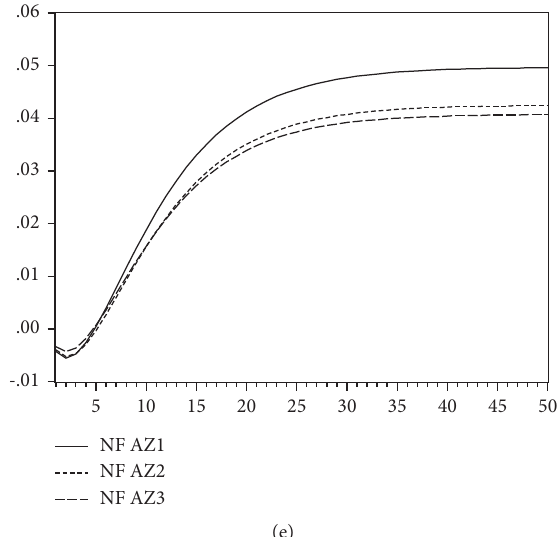
Figure 1: Technological innovation shock (1%), the dynamic response of variables under different degrees of investment openness. Note:1. The solid line, the short dotted line, and the long dotted line represent the τ value at 0.01, 0.10, and 0.20, respectively. Note: 2. SF represents the share of outward investment, Q represents the asset price difference, CA represents current account, VA represents the valuation effects, and NFA represents national external wealth. SFZ represents the impulse response route of SF after being impacted by technology in- novation (Z); then SFZ1, SFZ2, and SFZ3 represent the dynamic trend of the share of outward investment impacted by technology innovation when the τ value is at 0.01, 0.10, and 0.20, respectively. Q , CA, VA, and NFA express the same meaning as